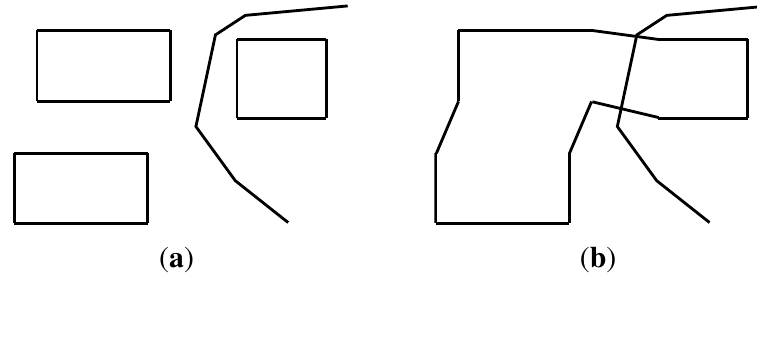
Figure 5. The merging of the polygons in ( a ) introduces a geometrical intersection with the line as illustrated in ( b